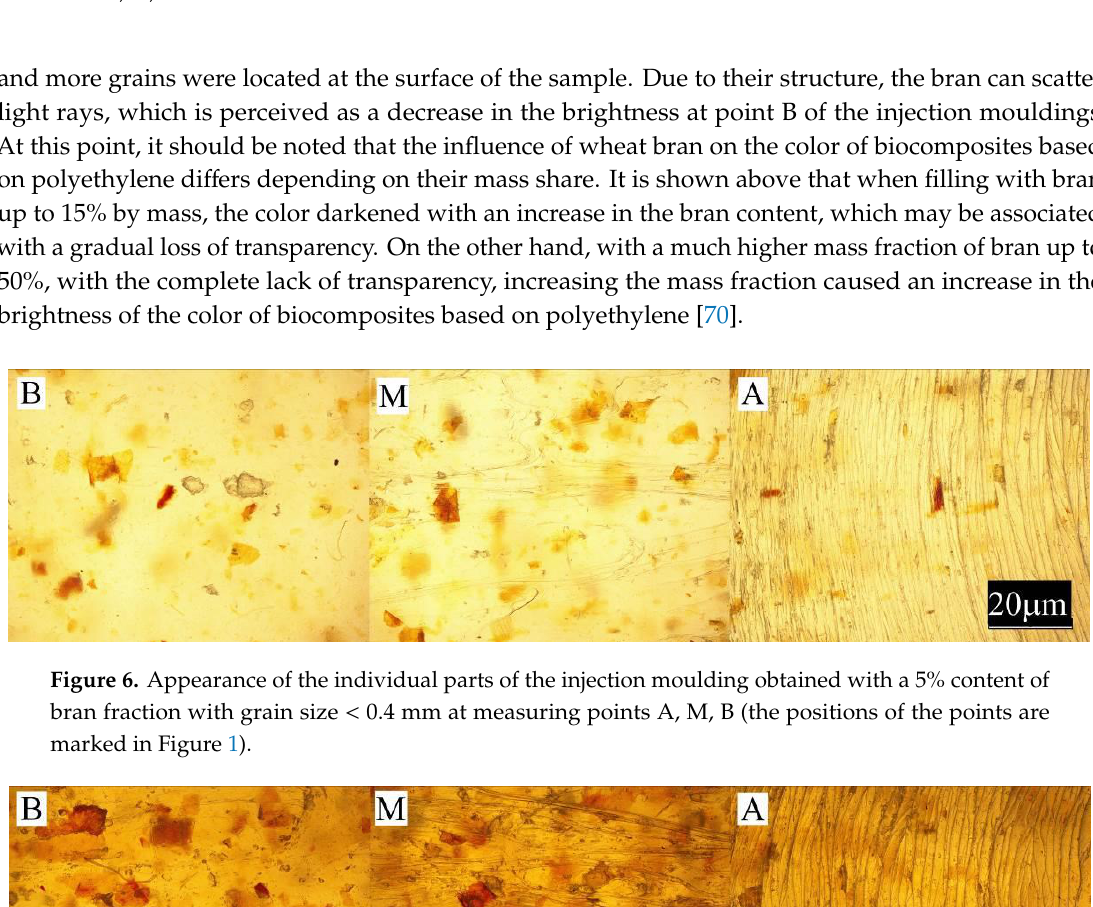
Figure 7. Appearance of the individual parts of the injection moulding obtained with a 15% content of bran fraction with grain size <0.4 mm at measuring points A, M, B (the positions of the points are marked in Figure 1).